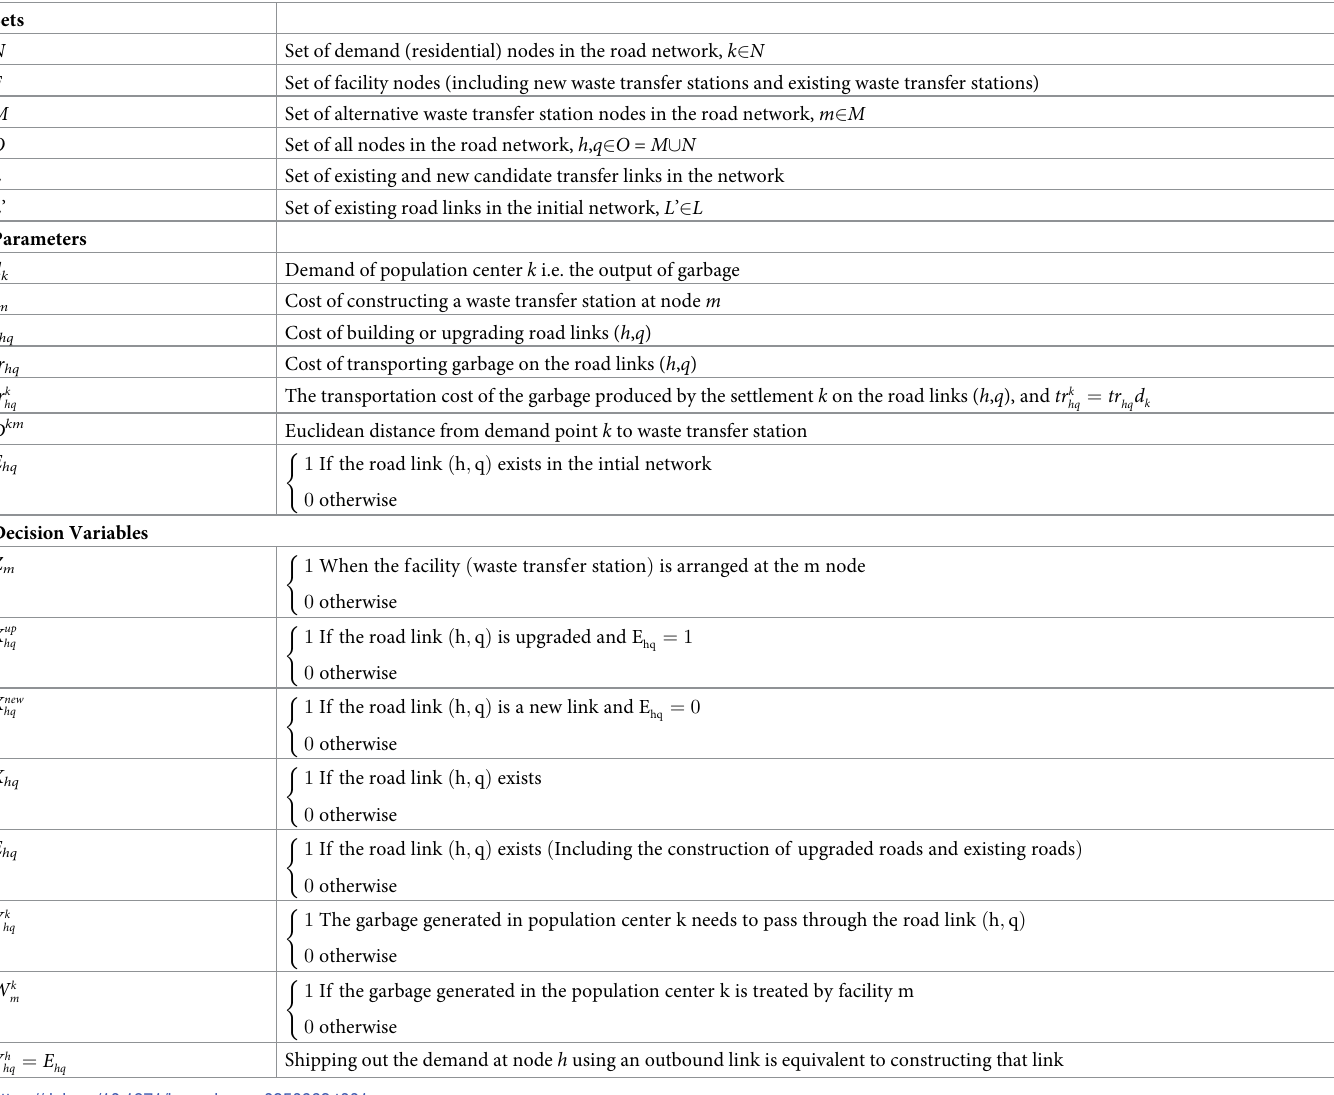
Table 1. The notations of the proposed